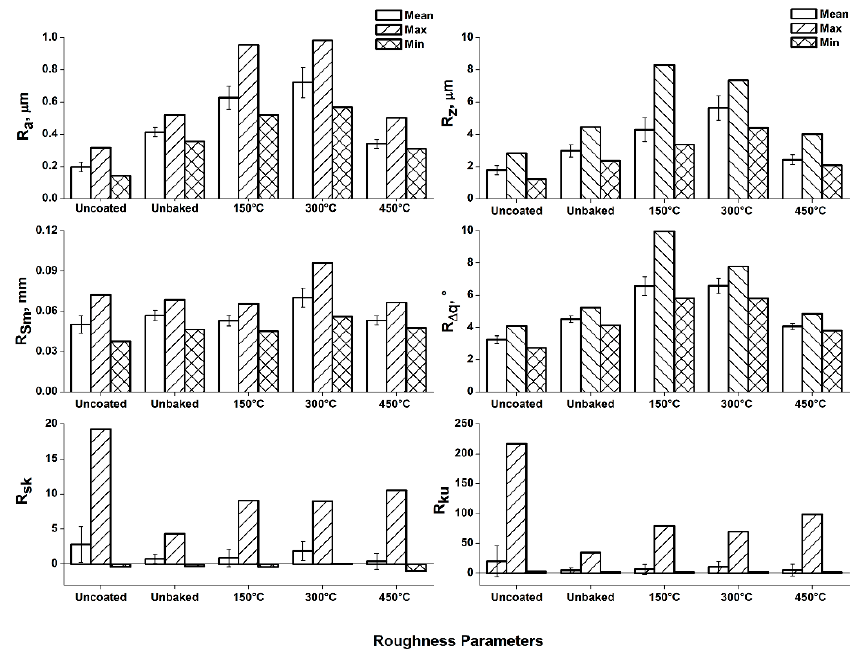
Figure 4. Roughness analysis of the samples surface.